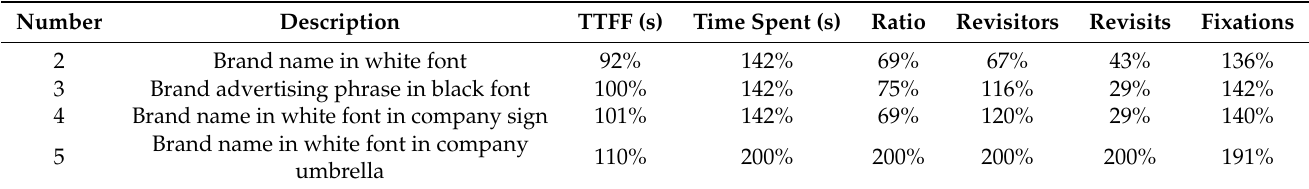
Table 5. Old website design: area of interest (AOI) metrics percentage difference against brand slogan in white font AOI in Table A3. Note: the brand slogan in white font AOI was removed from the table for relevance purposes, but the order remained the same. Furthermore, percentages were truncated to no decimal